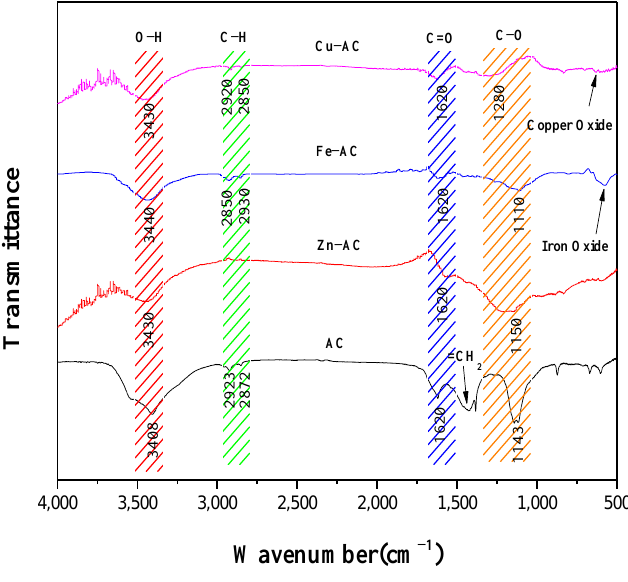
Figure 4. The FTIR spectra of the samples.